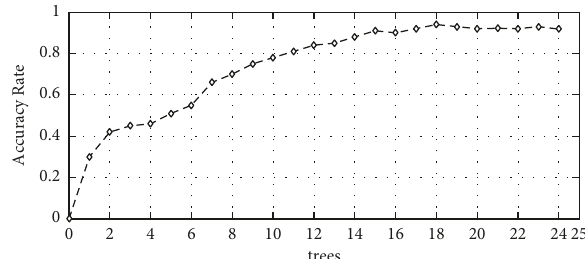
Figure 6: Changes in accuracy with the number of